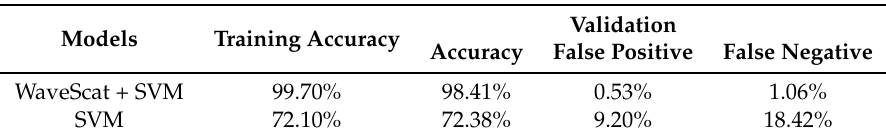
Table 2. Accuracy and confusion results of horizontal signals with or without wavelet scattering networks in the machine learning